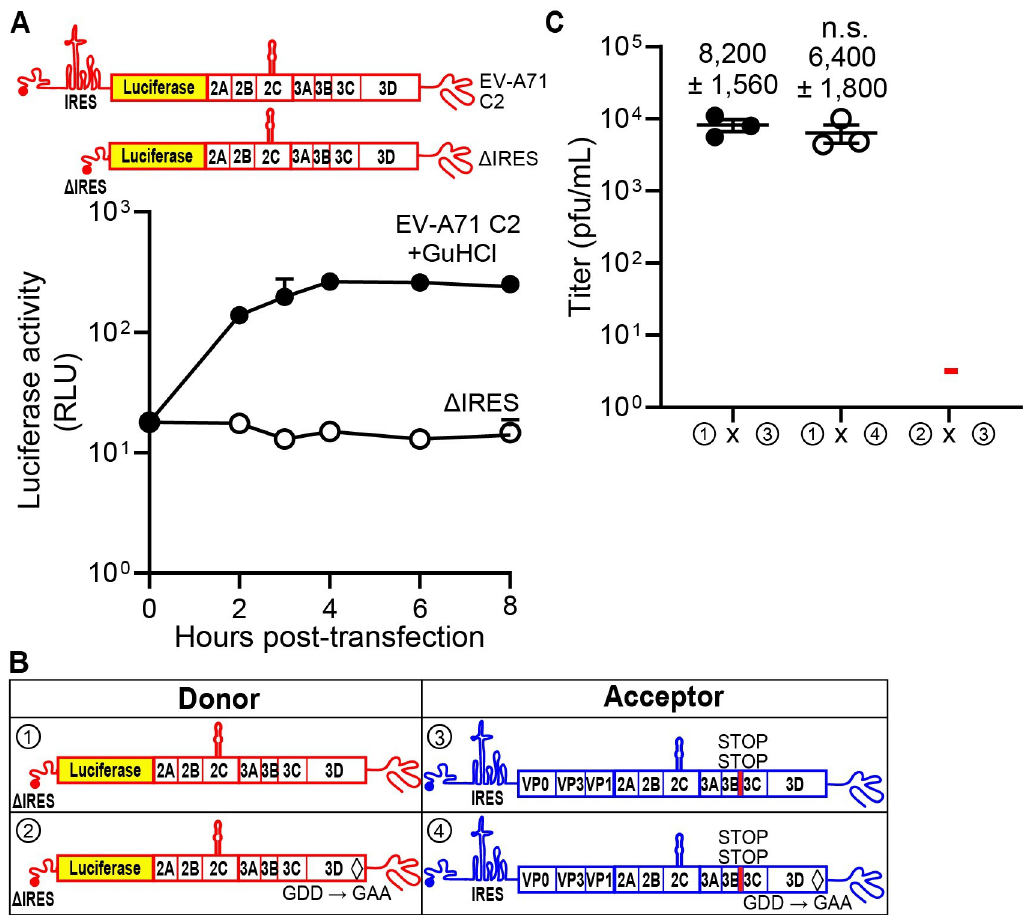
Fig 5. Evidence for IRES-independent translation of the enterovirus A71 genome. (A) Subgenomic replicon luciferase activity using an EV-A71 C2 subgenomic replicon with the entire IRES (nt 38–767) deleted ( Δ IRES)[15]. As a control, the WT subgenomic replicon RNA was transfected in the presence of GuHCl, a replication inhibitor. Luciferase activity is reported in RLUs as a function of time posttransfection. Numerical data provided as Supporting information (S1 Data). (B, C) Comparison of infectious virus generated between the indicated donor and acceptor RNAs with the specific modifications. The indicated set of donor and acceptor RNAs was cotransfected into RD cells. Results show titer of recombinant virus (pfu/mL ± SEM; n = 3 ).— indicates that plaques were not detected (limit of detection: 2 pfu/mL). Statistical analyses were performed using unpaired, two- tailed t test (n.s. indicates not significant). Viral recombinants were recovered only when the donor had an intact 3D gene encoding an active RdRp ( ① x ③ , ① x ④ ); viral recombinants were not recovered when the donor RNA encoded an inactive RdRp ( ② x ③ ). Numerical data provided as Supporting information (S1 Data). GuHCl, guanidine hydrochloride; IRES, internal ribosome entry site; RD, rhabdomyosarcoma; RdRp, RNA-dependent RNA polymerase; RLU, relative light unit; WT, wild type. observe viral proteins (anti-3D in the column marked WT in Fig 7 ). However, PI4P was also induced in the presence of GuHCl (anti-PI4P in the column marked WT + GuHCl in Fig 7 ) [41]. Under these conditions, viral proteins were not detected (anti-3D in the column marked WT + GuHCl in Fig 7 ) [41]. Deletion of the IRES also causes induction of PI4P in the absence (anti-PI4P in the column marked Δ IRES in Fig 7 ) and presence of GuHCl (anti-PI4P in the column marked Δ IRES + GuHCl in Fig 7 ). The same is not true for a full-length genomic RNA containing stop codons following 3B-coding sequence, which would preclude produc- tion of 3CD (anti-PI4P in the column marked 3B STOP in Fig 7 ). These observations provide support for the expression of 3CD in the absence of the IRES at levels perhaps on par with those expressed by the WT subgenomic replicon in the presence of GuHCl.